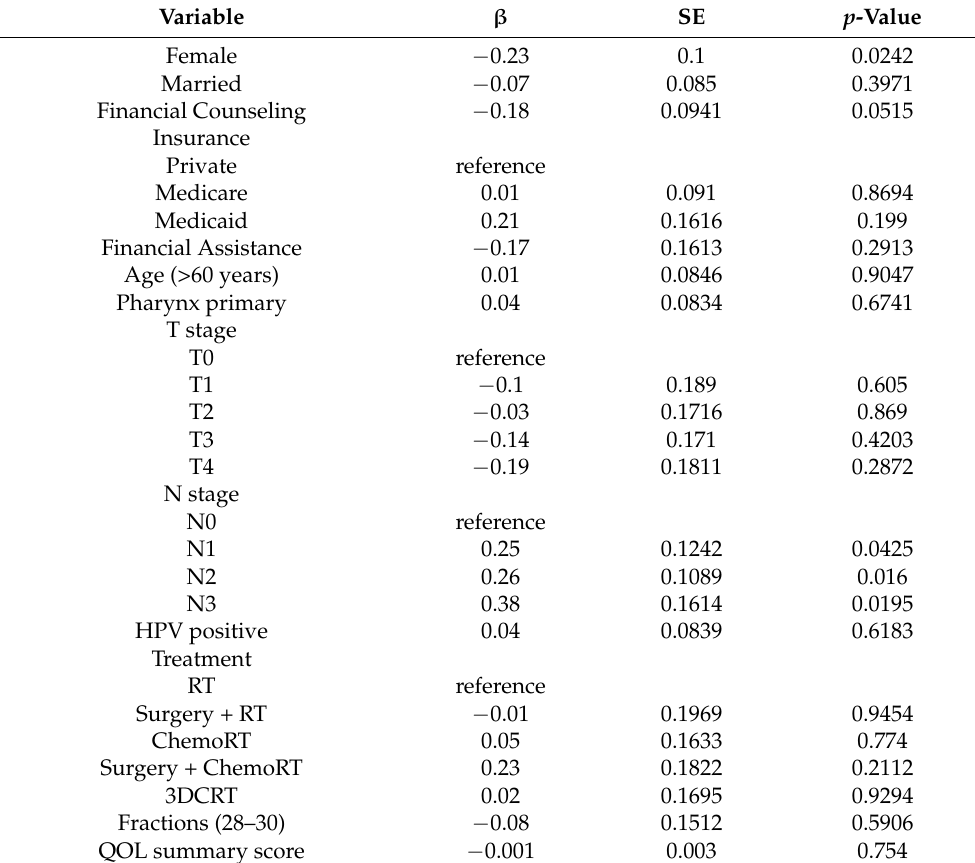
Table 3. Correlation with change in financial difficulty by linear